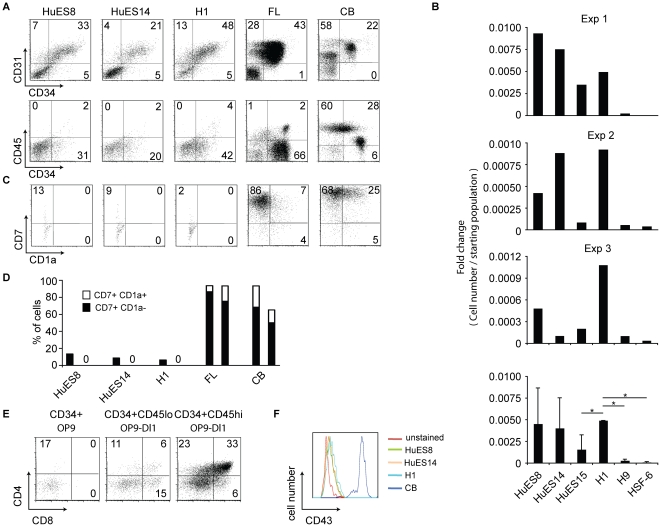
hESC-derived hematopoietic progenitor cells are phenotypically and developmentally distinct from in vivo hematopoietic precursors.(A) Significant phenotypic differences among hESC-derived, cord blood, and fetal liver hematopoietic progenitor cells. Representative plots of cell surface expression of CD34, CD31, and CD45 on differentiated hESCs (EB culture for 9 days), and CD34+ cell enriched cord blood and fetal liver. (B) Relative number of lymphocyte committed cells (as evidenced by expression CD7) as compared to input population (CD34+ population enriched by FACS from day 9 EBs.) Three independent experiments are shown (Exp 1–3). The bottom panel denotes the average of the three independent data sets (Exp 1–3), after normalization to the fold change of the H1 sample in each experiment. Standard deviations between hESC cells with p<0.05 (*) are also indicated. (C) Analysis of CD7 and CD1a expression from FACS enriched EB-derived, fetal liver, or cord blood CD34+ cells differentiated on OP9-hDL1 co-cultures for 14 days. (D) The proportion of T lineage-committed cells was determined by flow cytometric analysis of CD7 (lymphocyte) and CD1a (T cell) expression. Duplicate experiments are shown as representative of differentiation of CD34+ cells into CD7+ cells in OP9-hDL1 co-culture conditions (Enriched CD34+ cells from HuES15, H9, and HSF6 hESC lines failed to expand/survive in co-culture with OP9-hDL1 and are thus not presented). (E) Representative flow plots of cell-surface CD4 and CD8 expression from fetal liver CD34+ subsets differentiated on OP9 (left) or OP9-hDL1 (center and right) cells for 28 days. Fetal liver cells expressing CD34 were sorted to >95% purity. Additionally, fetal liver subsets were also sorted on CD34+CD45lo or CD34+CD45hi populations due to a gradient of CD45 expression. Cells were co-cultured on either OP9 or OP9-DL1 as indicated. (F) Flow cytometric analysis of cell-surface CD43 staining on HuES8, HuES14, and H1-derived hematopoietic progenitors (EB culture, day 9) and human cord blood progenitors. Flow plots were gated on CD34+ cells.